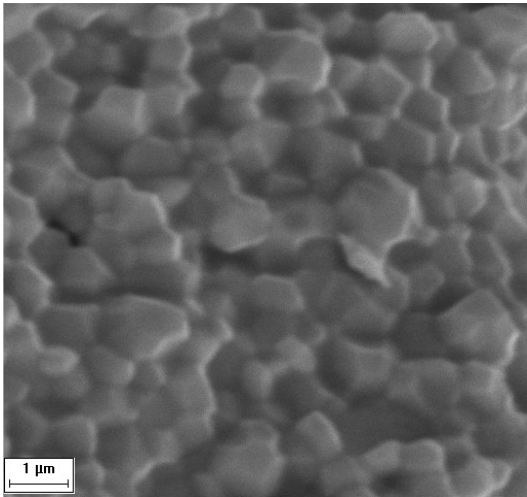
Figure 9. SEM image illustrating the microstructure of a ceramic sample of PZT:1,0%ErB.